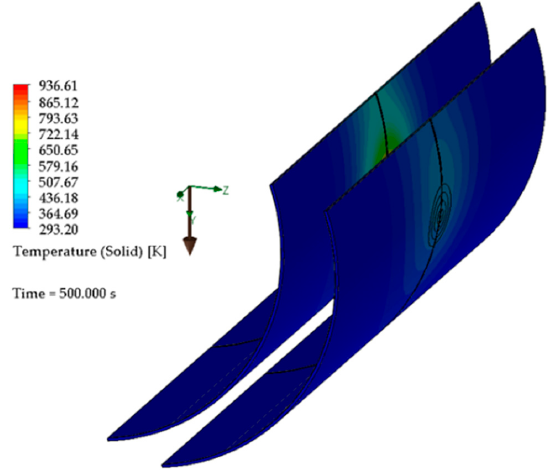
Figure 18. Temperature at 500 s.